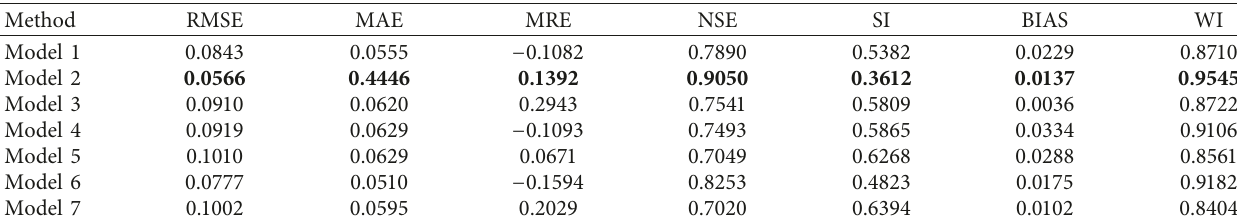
Table 4: The numerical evaluation indicators for the GA-DNN predictive model over the testing modeling phase.